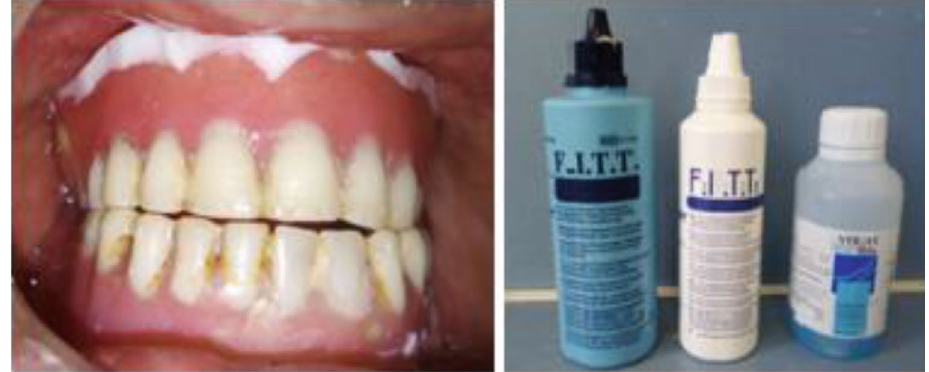
Figure 14: Tissue conditioning using soft tissue conditioner mixed with an anti-in fl ammatory